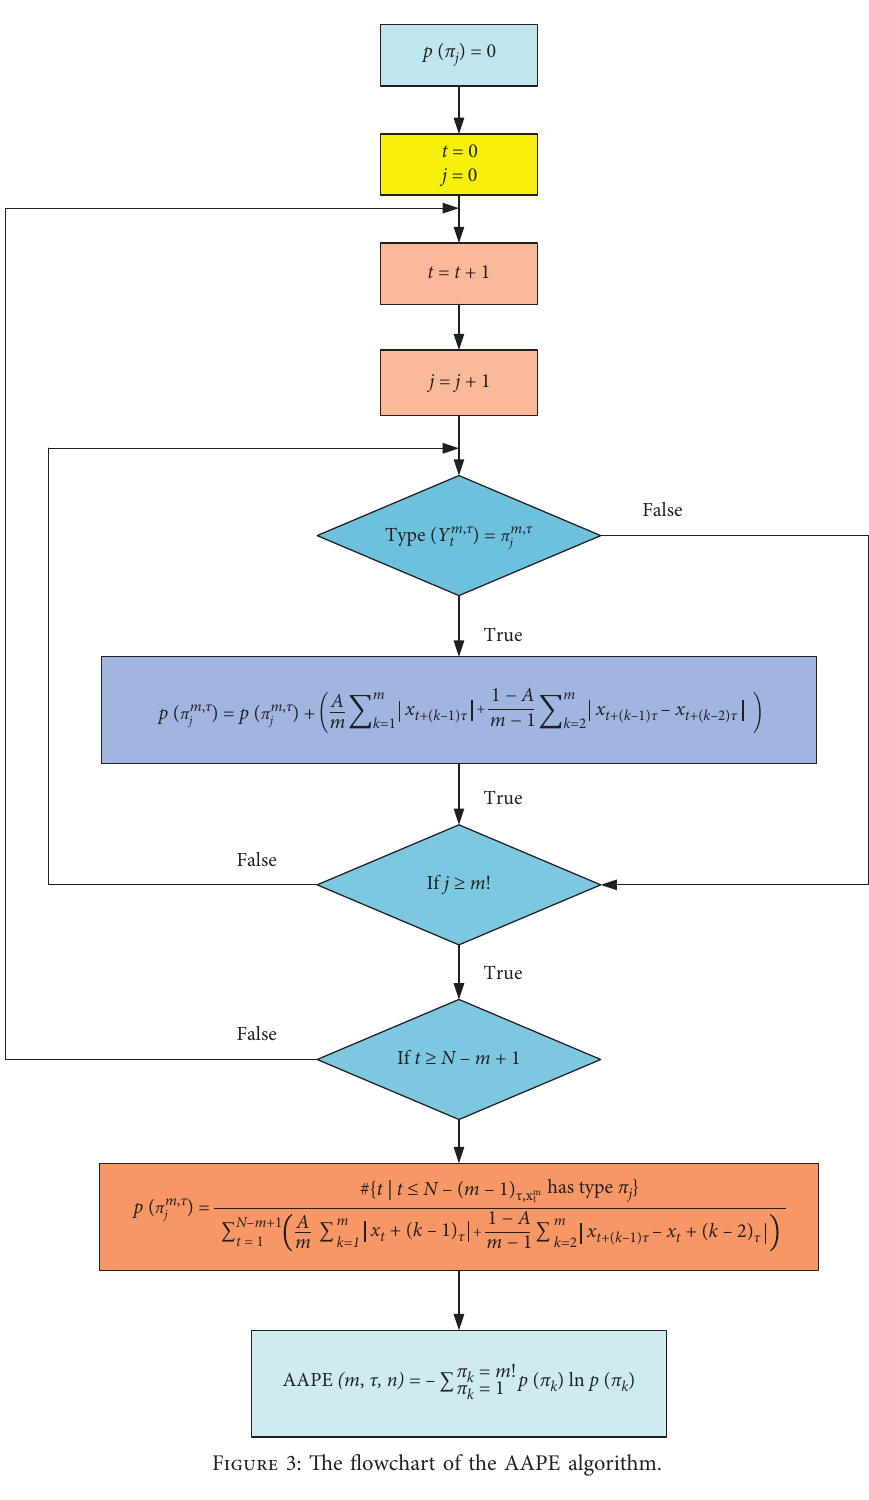
Figure 3: The flowchart of the AAPE